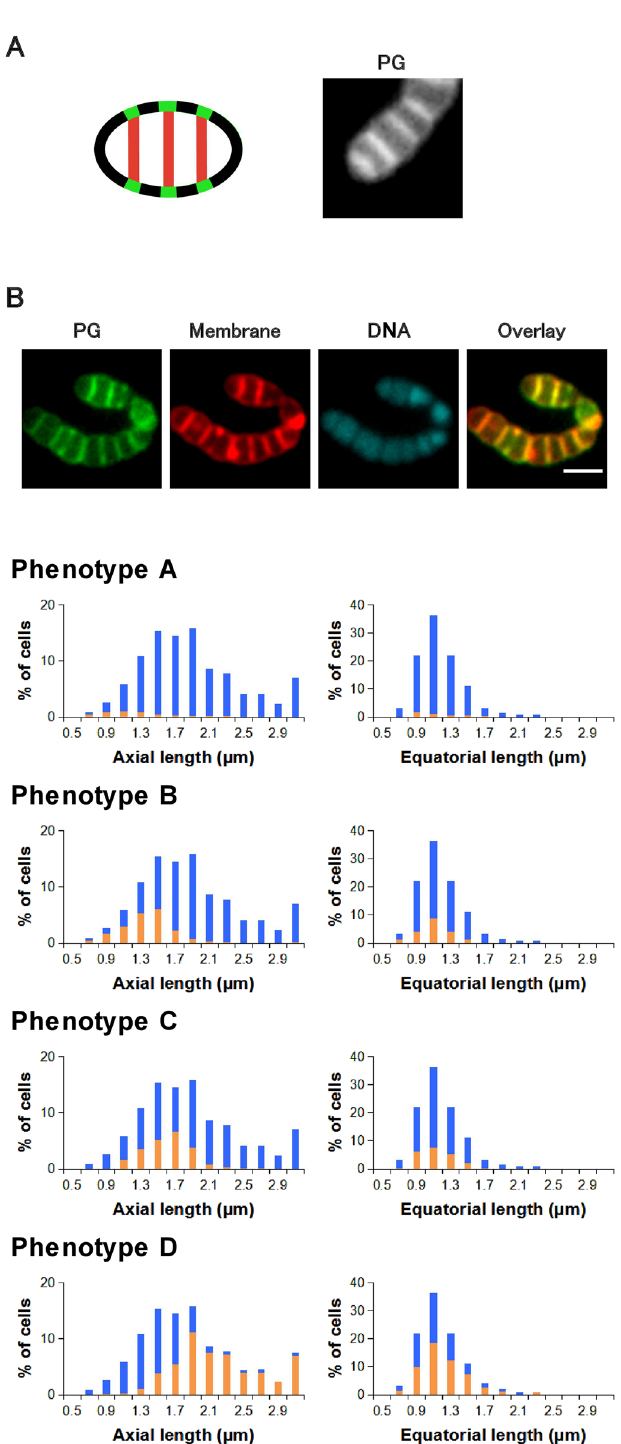
Figure 3. Average distribution of cell sizes and phenotypes of flavomycin (also known as moenomycin) (1 μ g/ mL)-treated Streptococcus pyogenes (n = 3). ( A ) Phenotype D represents cells with multiple septal growths (left: schematic presentation of phenotype D in flavomycin-treated S . pyogenes ; right: microscopic image of a phenotype-D cell stained using the sortase method). ( B ) Typical fluorescent images and cell size distributions of phenotypes A–D. Images: PG (growing peptidoglycan stained using the sortase method), Membrane (Nile red staining), DNA (DAPI), and Overlay (overlay of PG and Membrane images); scale bar: 2 μ m. Blue bars in histograms represent the cell size distribution of all cells. Orange bars in histograms represent the size distribution of cells with the indicated phenotypes. Statistical analysis regarding the histograms is available in Supplementary Table